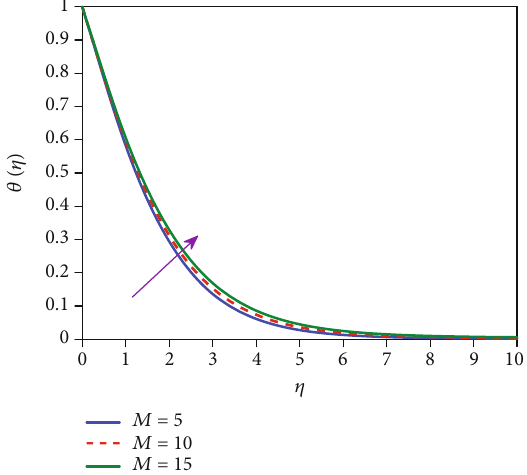
Figure 8: E ff ect of M on the temperature θ ð η Þ .